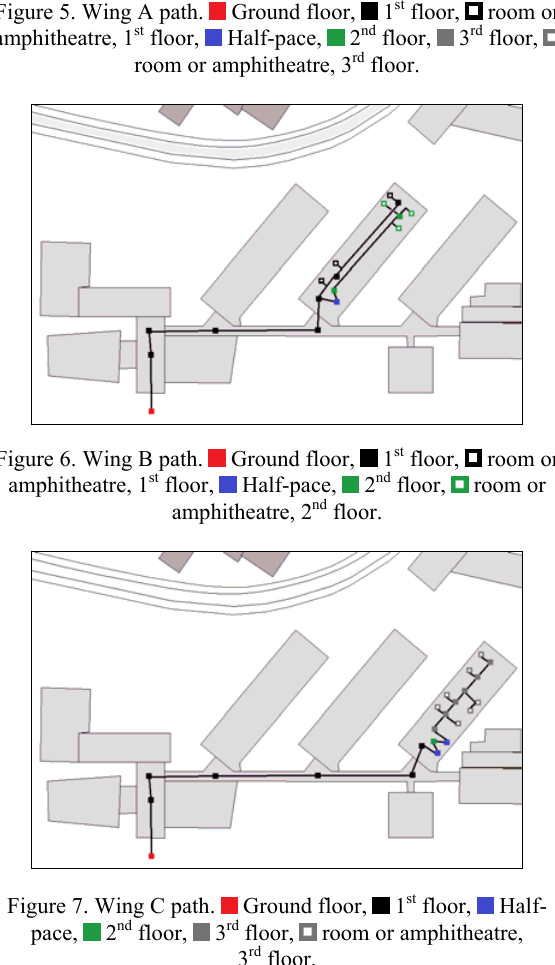
Figure 5. Wing A path.